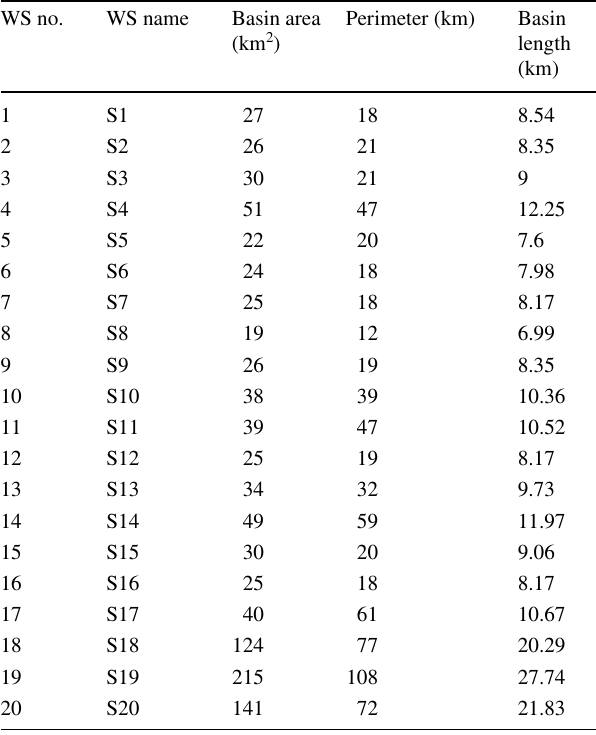
Table 3 Basin parameters of the proposed watershed WS no.